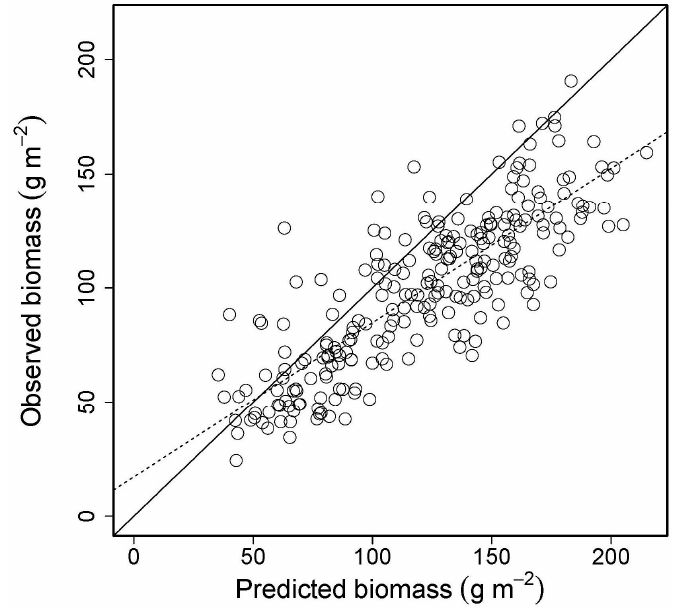
Figure 4. Relationship between observed biomass (g m − 2 ) of halophytic graminoids from Pt. Lonely, Alaska, 2012–2013, and the predicted biomass (g m − 2 ) based on the model log 10 (biomass) = 0.812 + 1.762(SR WV2 ) where NDVI values were derived at WorldView-2 (SR WV2 ) band definitions using a handheld spectrometer at the Colville River Delta, Alaska, 2012–2015. The solid line through the origin represents the slope of a 1:1 relationship, and the dotted line represents the actual relationship biomass observed = 17.17 + 0.676(biomass predicted ).